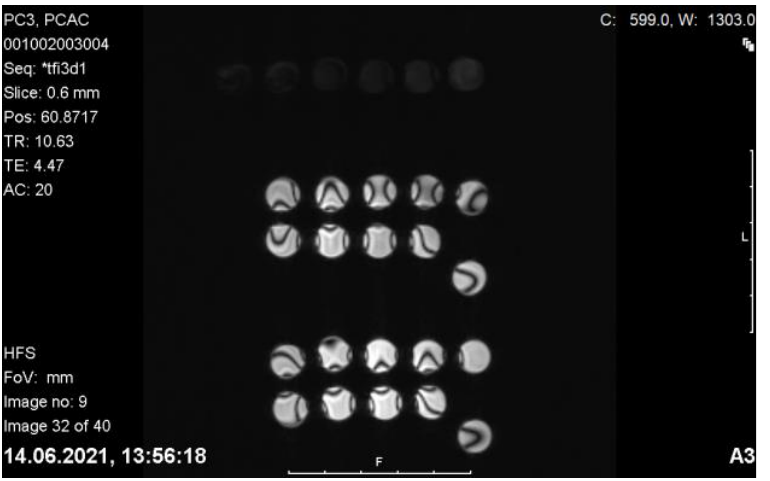
Figure 11. Relaxivity (R2): 0.421/3 T nanoconjugates applied on C-Fe 3 O 4 and PC-3 LNCaP) (n = 6).